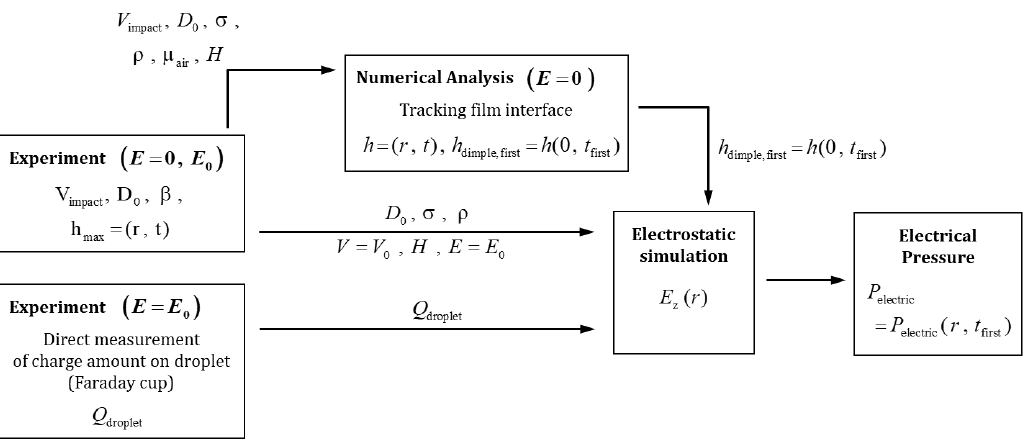
Figure 3. Flow chart to calculate the electric pressure ( 𝑃 electric ).